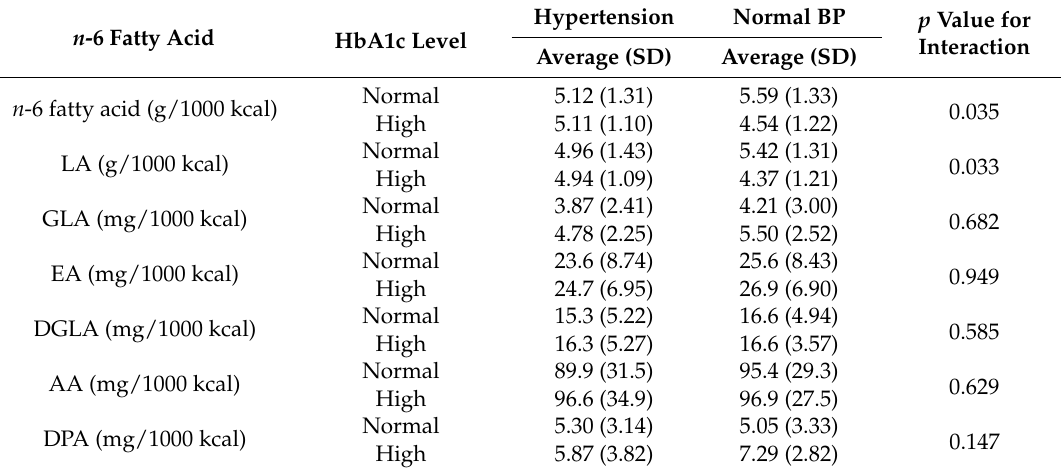
Table 3. Interaction between BP and HbA1c groups by n -6 fatty acid